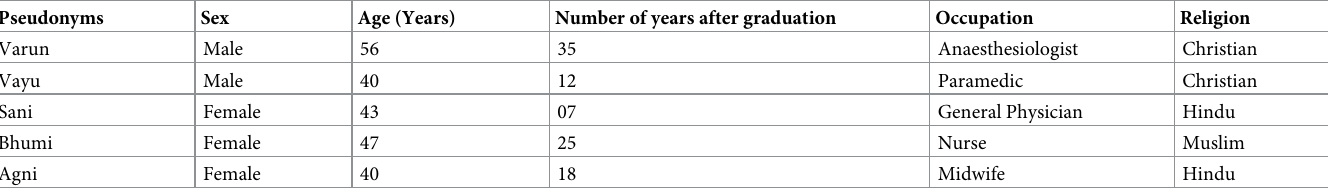
Table 1. Participant demographic